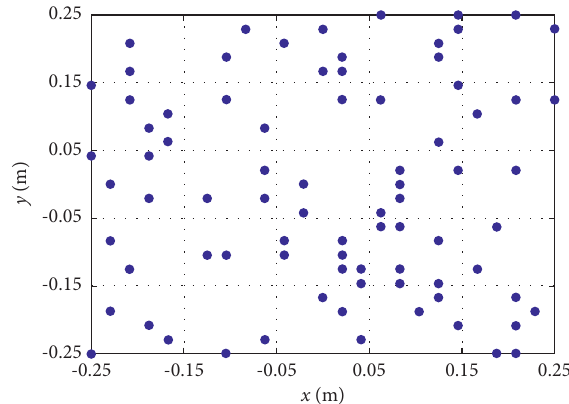
Figure 3: Distribution of holographic measurement points for compressive equivalent source method and proposed